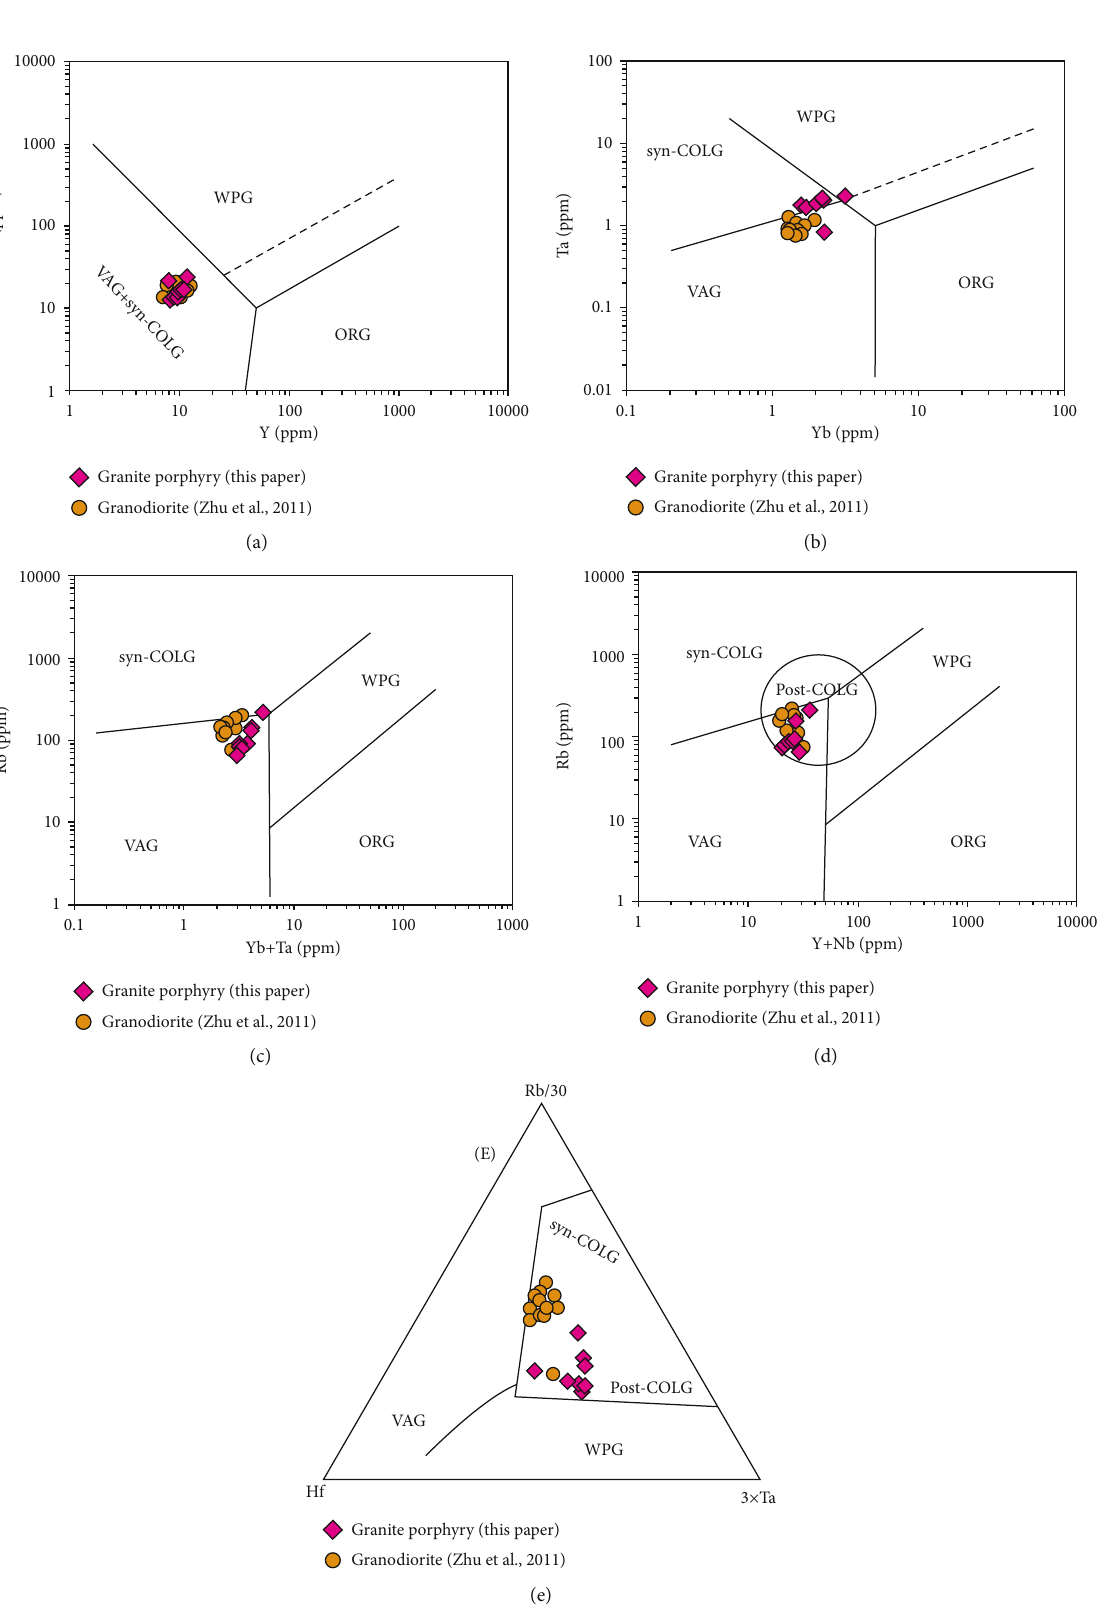
Figure 18: The tectonic setting discrimination diagrams for the granite porphyries and granodiorite of the Yangla copper deposit, Yunnan, China (after Maniar and Piccoli, 1989 [78]; Pearce et al., 1984 [81]). VAG: volcanic arc granite; sny-COLG: sny-collision granites; WPG: within-plate granites; ORG: oceanic ridge granites; post-COLG: postcollision granites: COLG: collision